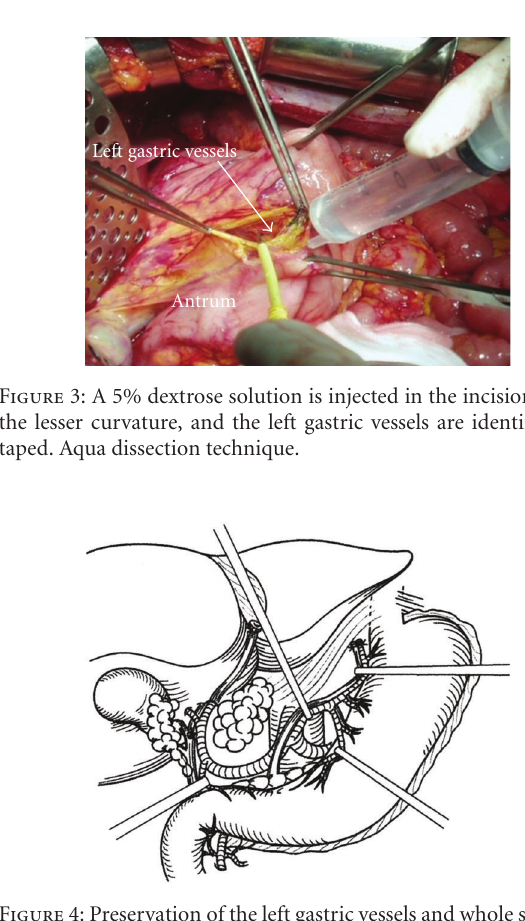
Figure 4: Preservation of the left gastric vessels and whole stomach. Surgical techniques of the removal of lesser omental